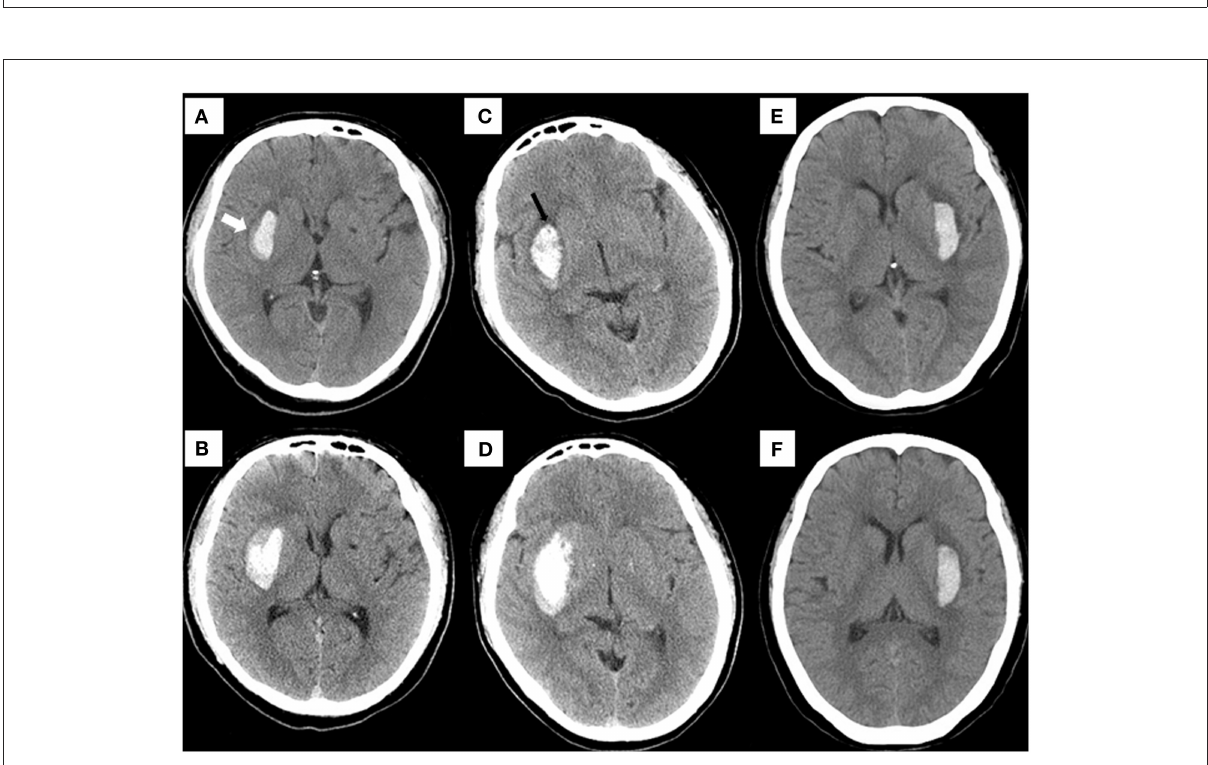
FIGURE8 Examples of using the nomogram to predict the risk of HE. Case 1: (A) a patient who underwent cranial NCCT within 1.5h of onset presented with a hematoma (6.1ml) in the basal ganglia. The risk of HE estimated by nomogram was approximately 71.36% (blend sign = present, hypodensities = absent, NLR = 10.22, time to initial NCCT < 3h, R-score = − 0.21, total points = 134, and estimated HE risk = 71.36%). A blend sign (white arrow) can be seen. (B) The hematoma volume was enlarged to about 11.8ml on the follow-up CT at 8 hours. Case 2: (C) a patient who underwent cranial NCCT within 2.5h of onset presented with a hematoma (10.1ml) in the basal ganglia. The risk of HE estimated by nomogram was approximately 70.78% (blend sign = absent, hypodensities = present, NLR = 13.03, time to initial NCCT < 3h, R-score = − 0.19, total points = 131, and estimated HE risk = 70.78%). A hypodensity sign (black arrow) can be seen. (D) The hematoma volume was enlarged to about 24.8ml on the follow-up CT at 10 Hours. Case 3: (E) using this nomogram, the hematoma (4.8ml) on the initial NCCT showed a low expansion risk (blend sign = absent, hypodensities = absent, NLR = 2.52, time to initial NCCT > 3h, R-score = − 1.59, total points = 30, and estimated HE risk = 1.99%). (F) At 22.5h after onset, the follow-up CT detected a hematoma of similar size (5.2ml). NCCT, noncontrast computed tomography. HE, hematoma